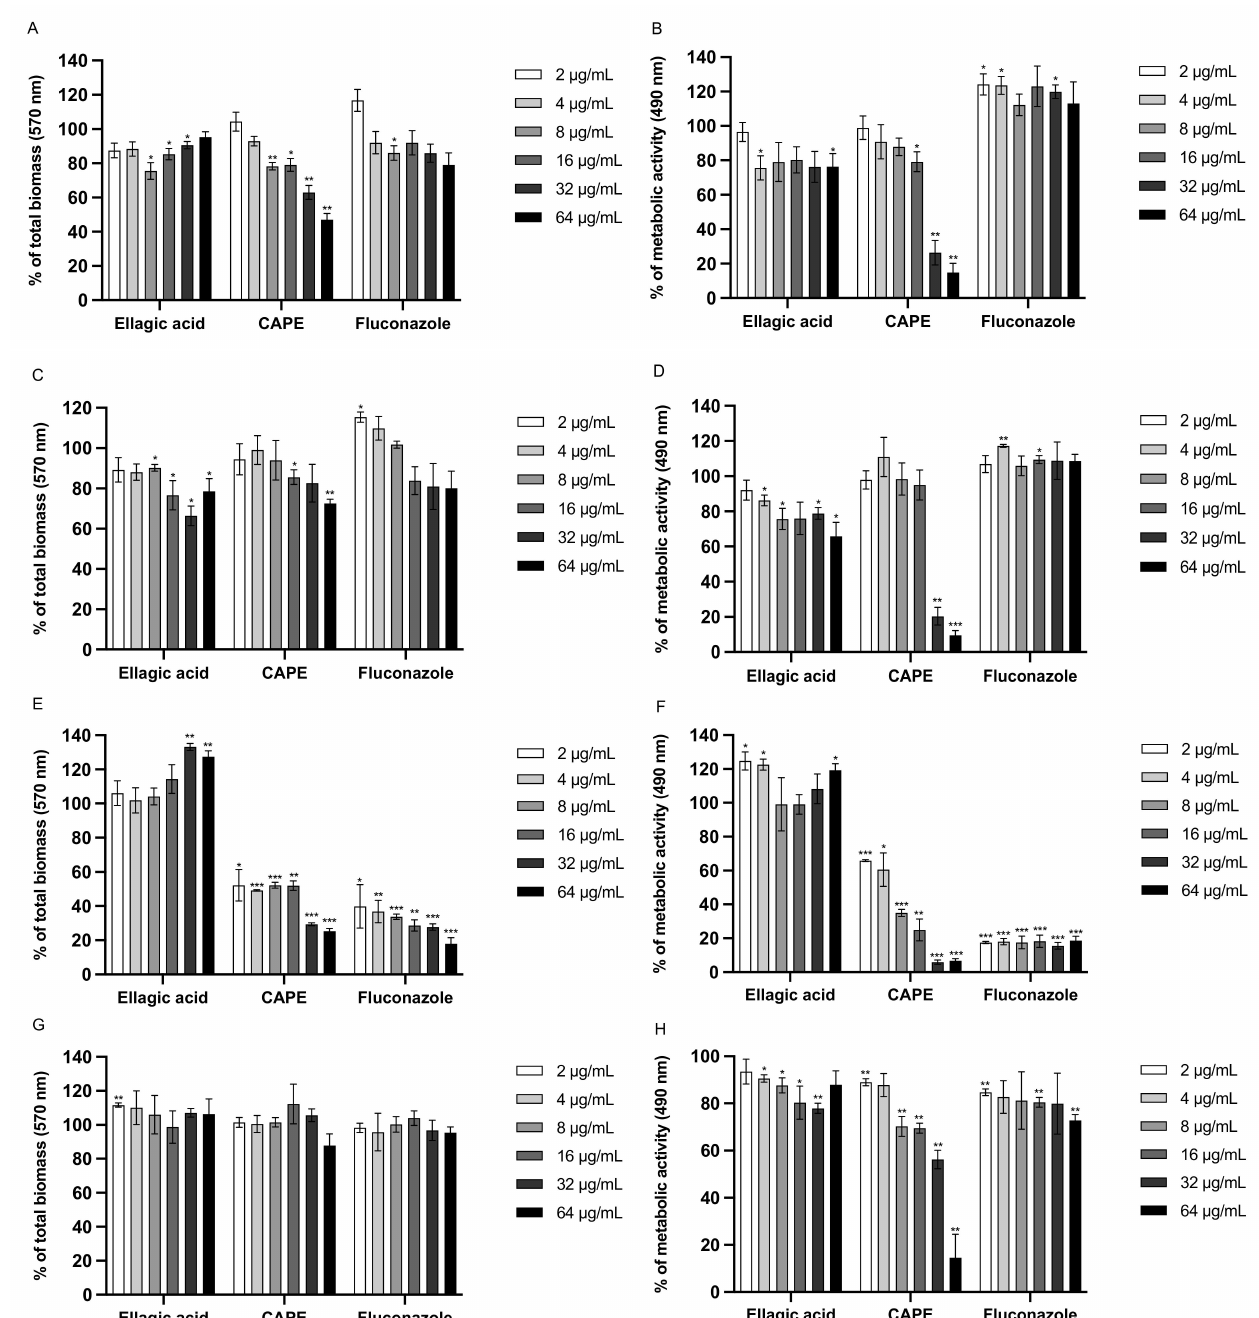
Figure 3. Inhibition of biofilm formation ( A , B , E , F ) and eradication of mature biofilm ( C , D , G , H ) by EA, CAPE, and FLC against C. auris CAU-04 ( A – D ) and C. albicans SC5314 ( E – H ) strains. Two different methodologies were used to quantify biofilm: crystal violet assay ( A , C , E , G ), which measures biofilm total biomass, and XTT assay ( B , D , F , H ), which measures metabolic activity. Data represent the mean ( ± standard deviation, SD) of three independent experiments, and each one was carried out with triplicate determinations. For all experimental points, * p < 0.05, ** p < 0.01 or *** p < 0.001 were obtained for treated samples versus control (100% of biofilm formation and metabolic